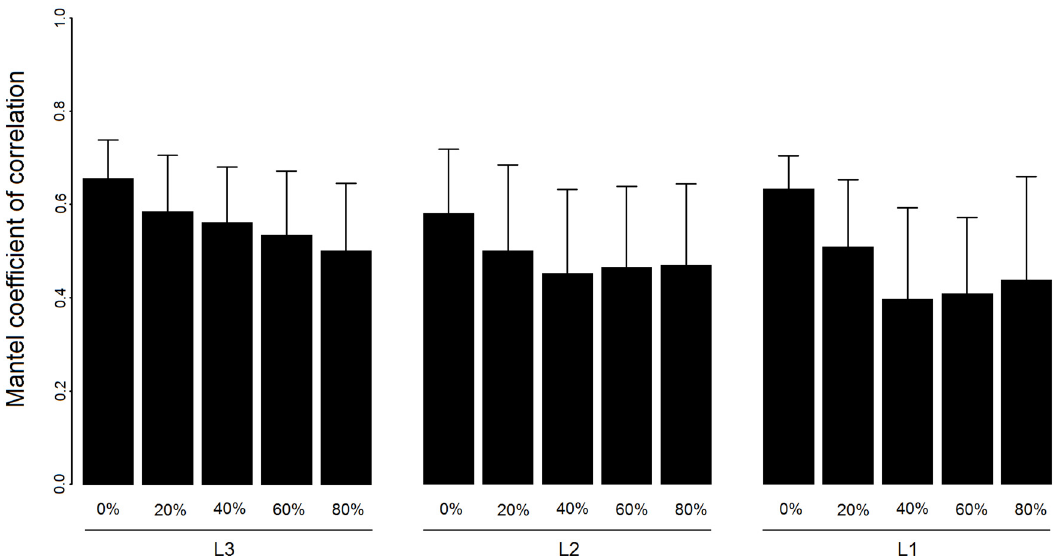
Fig 6. Correlations between observed and simulated genetic structures for the various scenarios of landscape composition and configuration. Landscapecompositionwas determined by the three levels of the reef typology describedin Table 2. Landscapeconfiguration is determined by habitat fragmentation (0% refers to the initial habitat maps, while20%, 40%, 60% and 80% refer to reductionlevels of habitat area compared to the initial habitat map). The coefficient of correlation is the Mantel coefficient of matrix correlation.We used the dispersalkernel that provided the best congruence betweenthe observedand simulatedgeneticdistances (IBD). Bars are mediansand error bars are quantile95%.